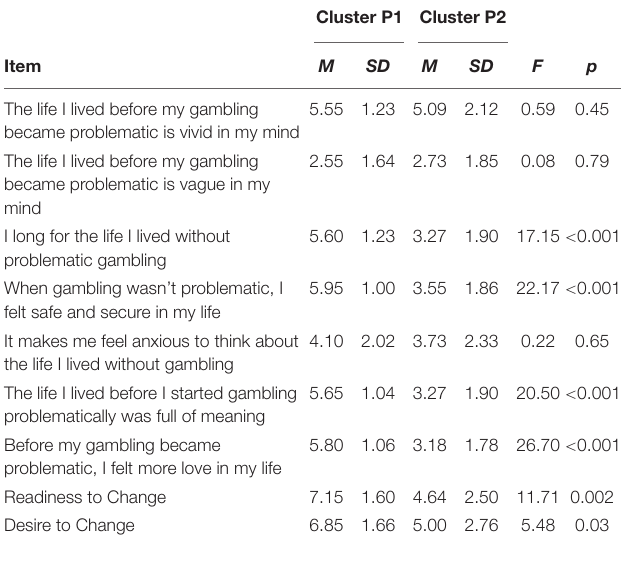
TABLE 3 | Past perception ratings and behavior change measures between past